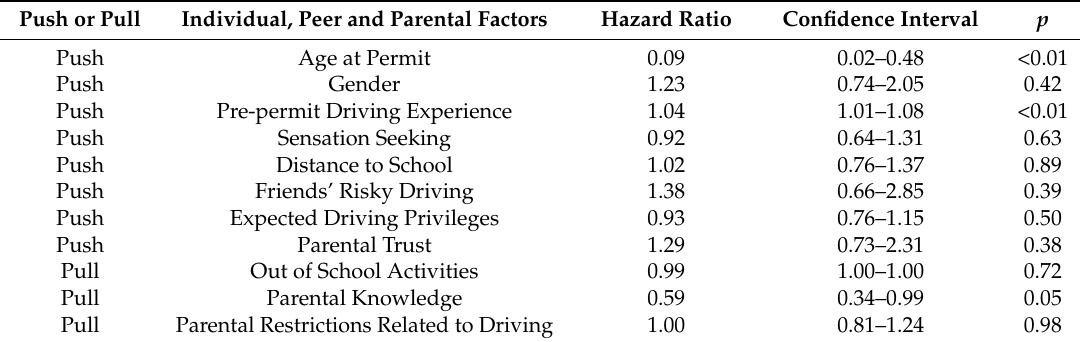
Table 3. Factors Influencing Time to Independent Licensure (N =